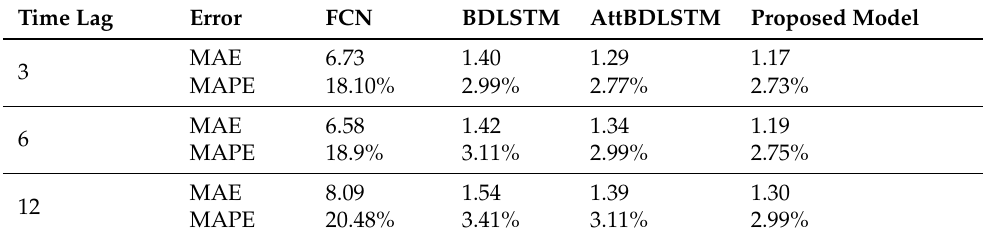
Table 4. Ablation